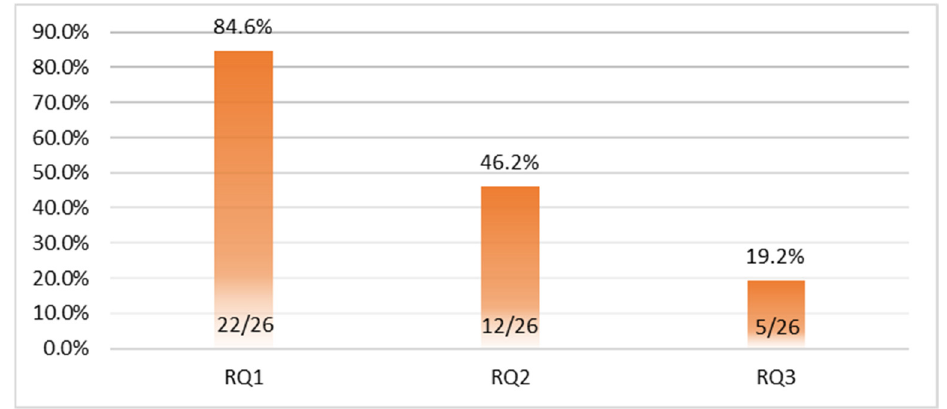
Figure 7. Number of papers by type.